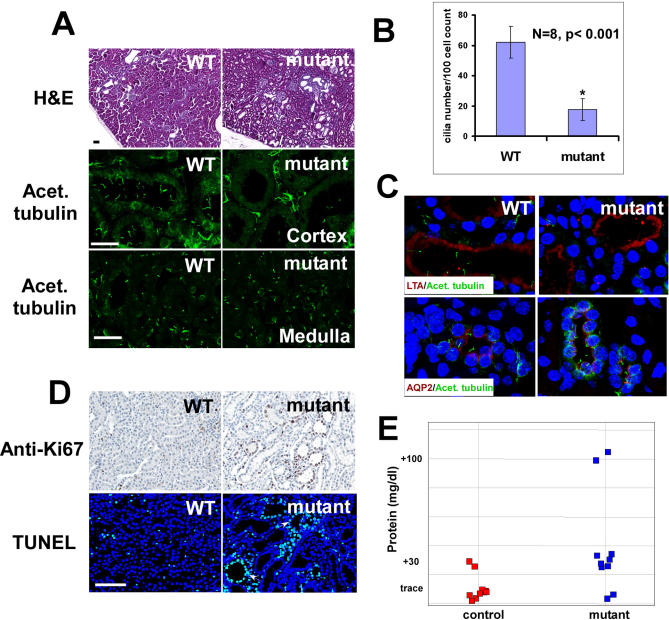
Kidney Abnormalities in Alms1 Mutant Mice(A) H&E-stained kidney sections of a 6-mo-old Alms1L2131X/L2131X mouse showing dilated cortex tubules compared with an age-matched wild-type control. Lack of kidney cilia is observed in some tubules in the cortex of Alms1L2131X/L2131X kidney, whereas cilia in the medulla appear normal. H&E, hematoxylin-eosin; Acet, acetylated.(B) Cortex cilia count comparison between Alms1L2131X/L2131X and controls. 300–400 kidney nuclei were examined for each of six fields of Alms1L2131X/L2131X and wild-type controls. The bar chart represents the average and standard deviations of cilia count per 100 kidney cortex epithelial cells from eight mice per group.(C) In the cortex of Alms1L2131X/L2131X kidney, cilia are lost selectively in LTA-labeled tubules but not in aquaporin-2-expressing tubules.(D) Upper panel: clusters of Ki67-positive proliferating epithelial cells in the Alms1L2131X/L2131X kidney, potentially lining the same convoluted tubule. Lower panel: TUNEL staining reveals apoptotic cells in Alms1L2131X/L2131X kidneys but rarely in a wild-type control. Arrow, whole tubule cross sections were labeled by TUNEL, suggesting progression of nephropathy in Alms1L2131X/L2131X mutant kidneys. WT, wild-type.(E) Urinalysis of 3- to 6-mo-old Alms1L2131X/L2131X mice and age-matched littermate controls. Urine from Alms1L2131X/L2131X mice showed slight elevation of protein levels, p = 0.007. Scale bars, 50 μm.